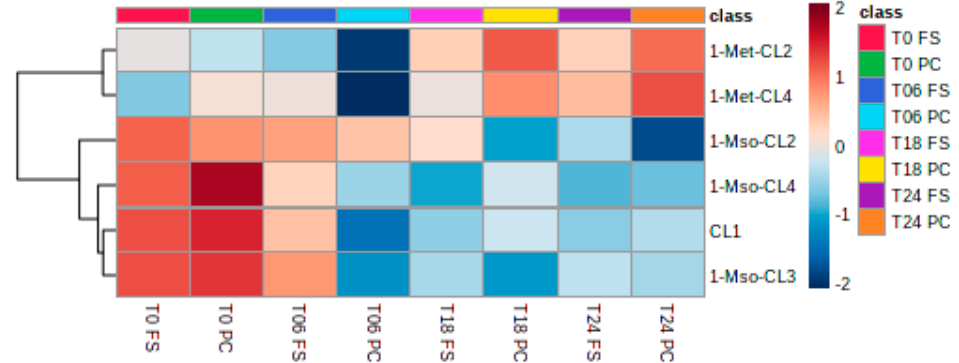
Figure 6. Heatmap of the metabolism of cyclolinopeptides during fermentation. T0, T6, T18, T24 = observed timepoints 0 h, 6 h, 18 h, and 24 h; PC = digested flaxseed press cake, FS = digested milled whole flaxseed.